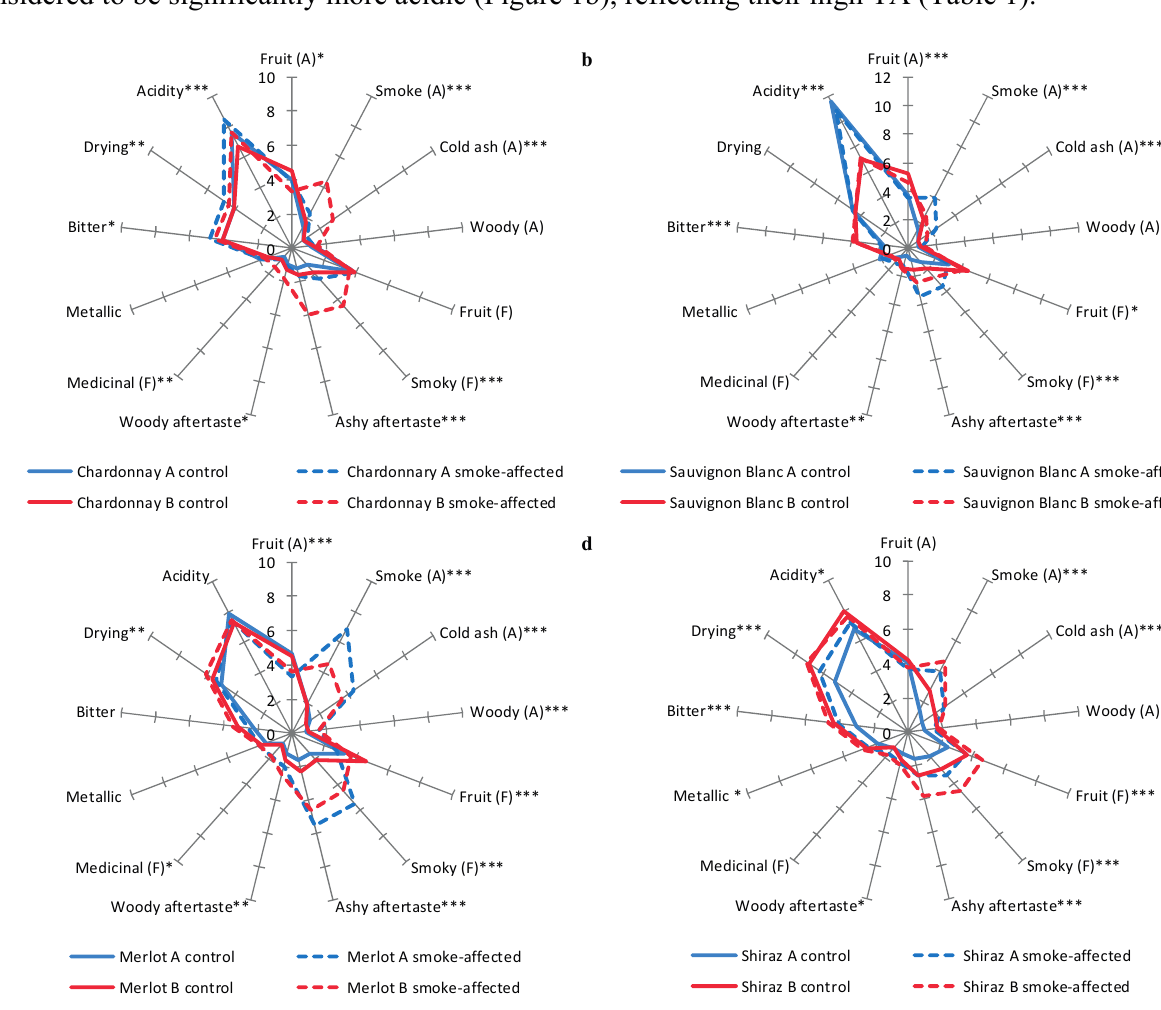
Figure 1. Mean ratings for sensory attributes of ( a ) Chardonnay ( b ) Sauvignon Blanc ( c ) Merlot and ( d ) Shiraz wines, made from control and smoke-affected grapes harvested at two different levels of maturity; A = aroma; F = flavor; (*: p < 0.05; **: p < 0.01, ***: p <